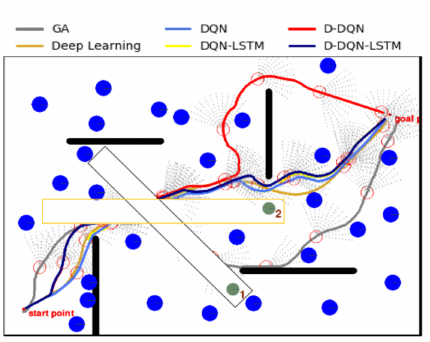
Figure 16. Planning capabilities of six algorithms in a complicated